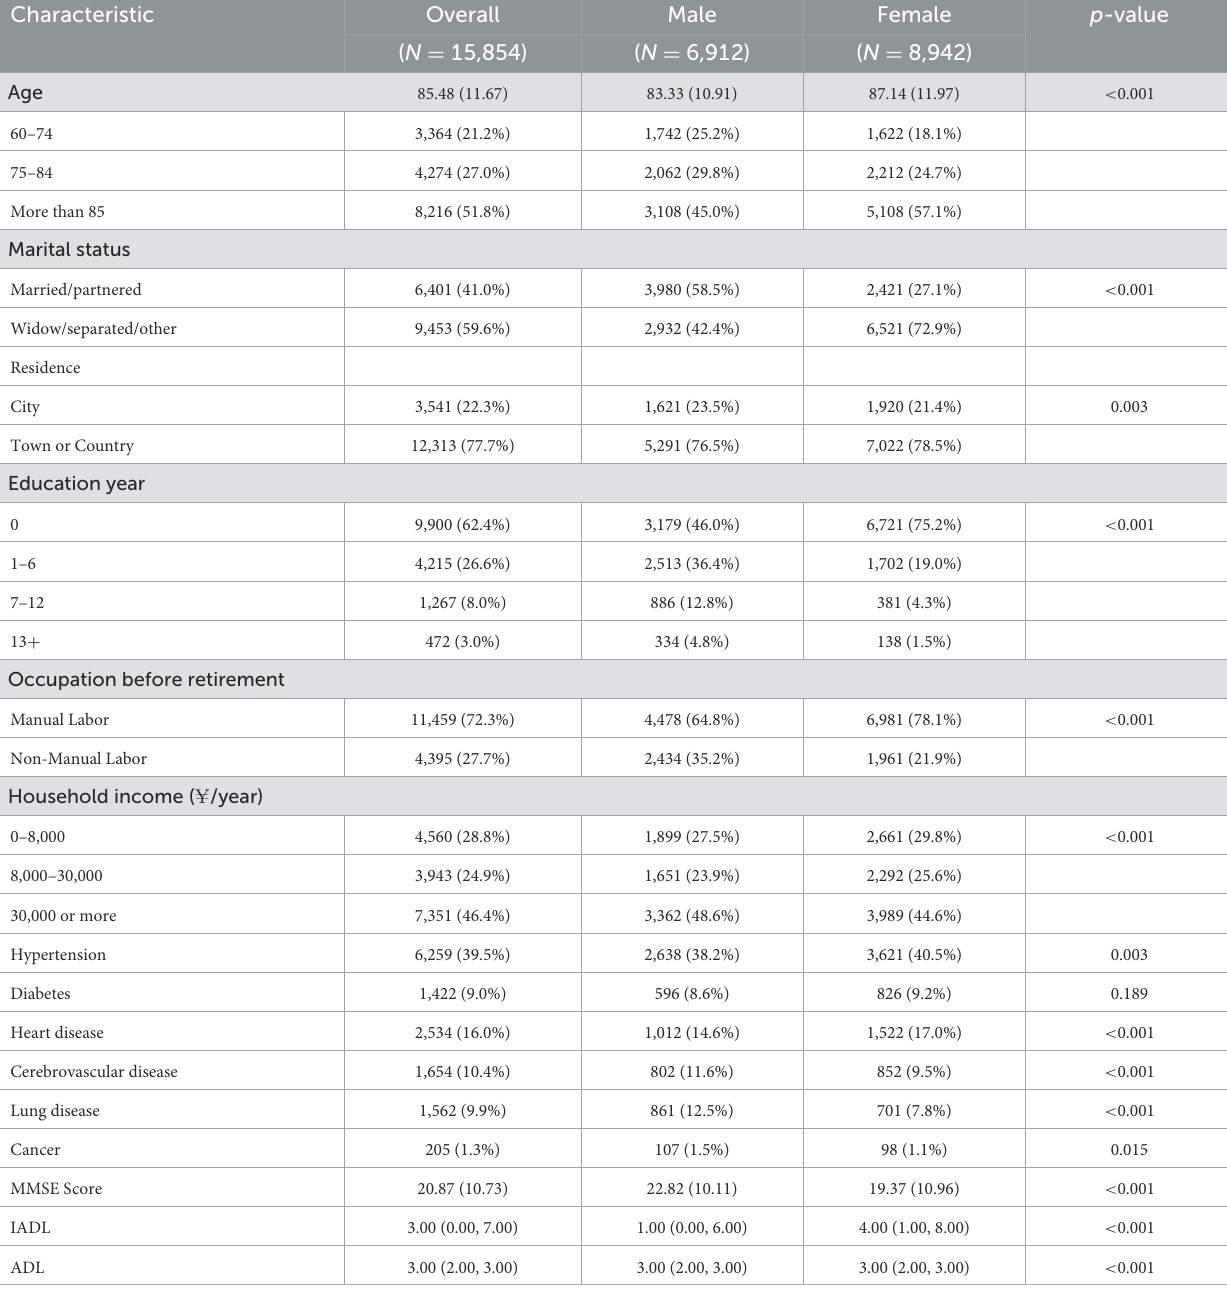
TABLE 1 Baseline characteristics of CLHLS 2018